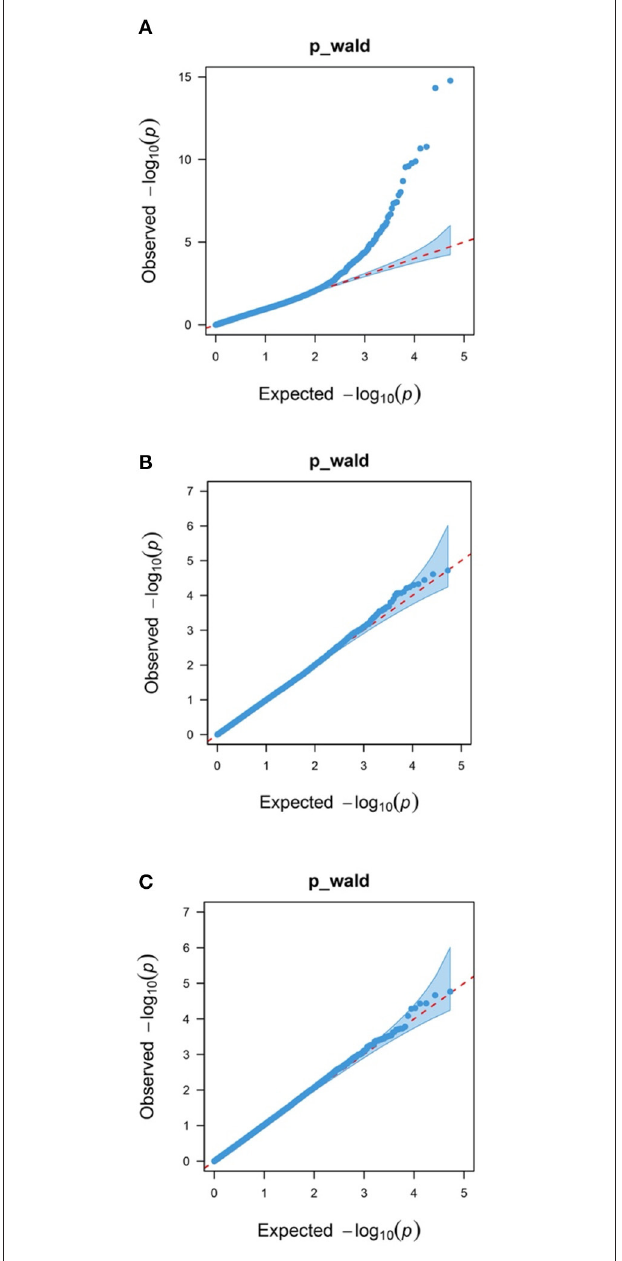
FIGURE 2 | Quantile–quantile plots of body weight traits using a mixed linear model approach. Blue dots represent the –log 10 ( P -value) of the entire study, and the red line represents the expected values under the null hypothesis of no association. (A) Birth weight (BW); (B) weaning weight (WW); and (C) yearling weight